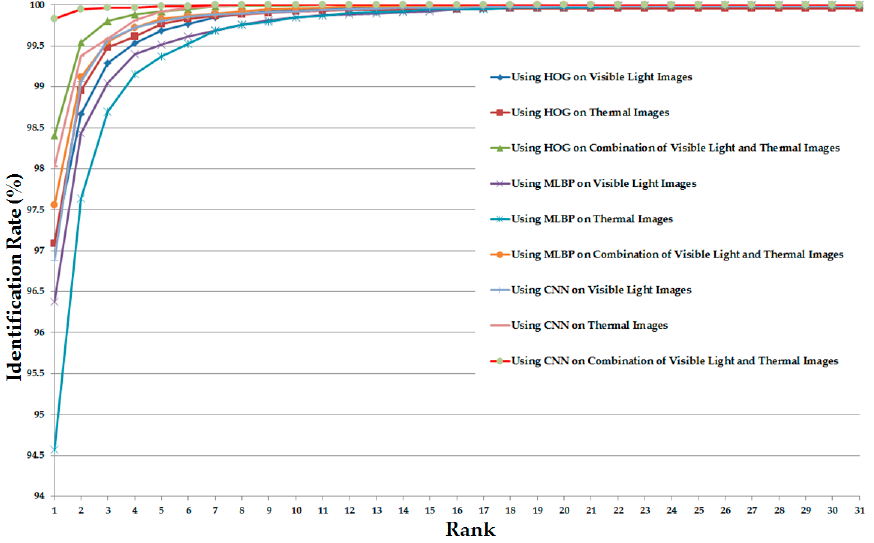
Figure 15. CMC curves using correlation with various system configurations for the identification problem. Table 7. Verification accuracy (EER) of the recognition system using correlation distance with PCA applied on the extracted image features (unit: %).